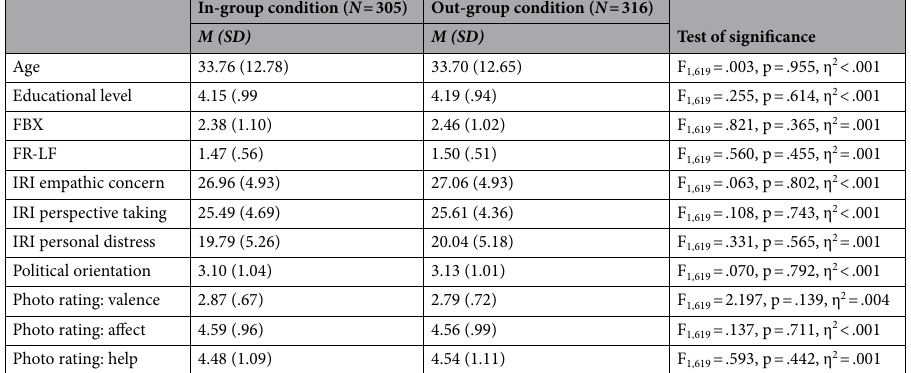
Table 1. Mean scores in the samples being presented with photos of in-group versus out-group people in need. FBX fear-based xenophobia, FR-LF right wing extremist attitudes, IRI interpersonal reactivity index; political orientation (1 = left, 7 =